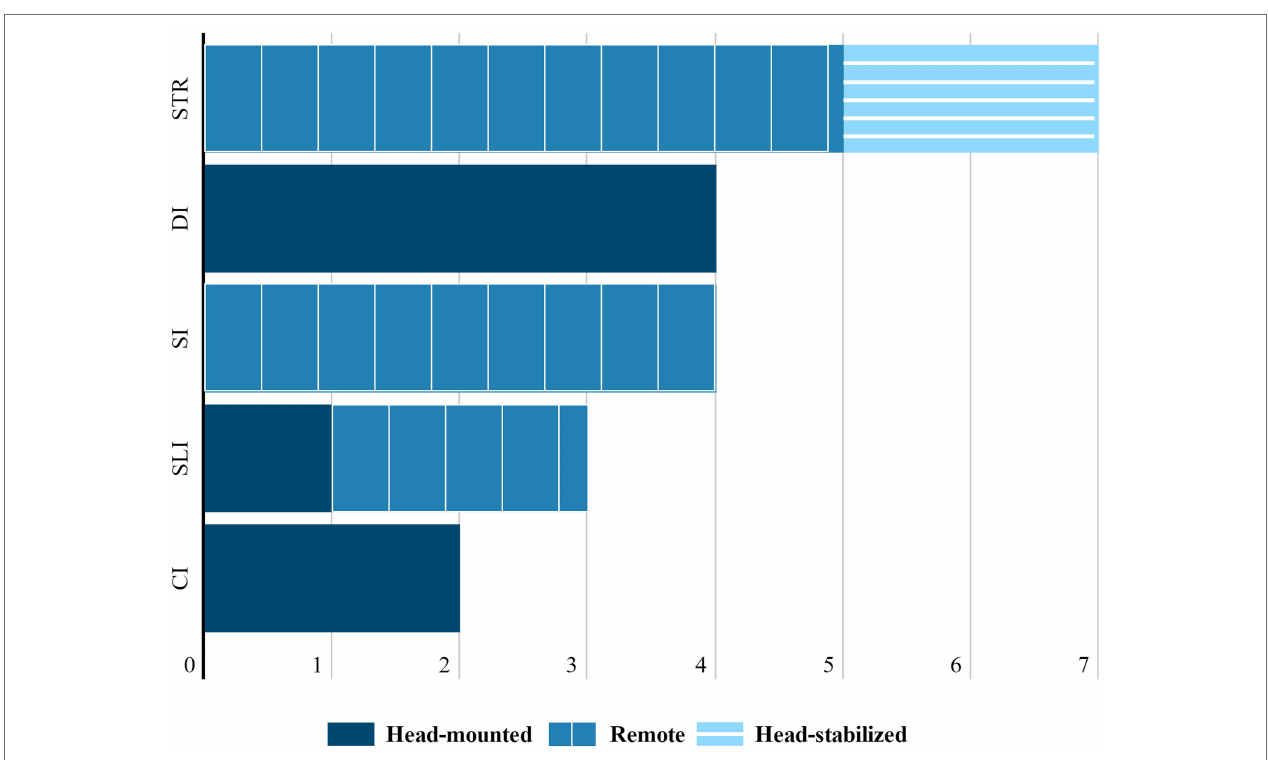
FIGURE 4 | Choice of eye trackers for investigation of different interpreting